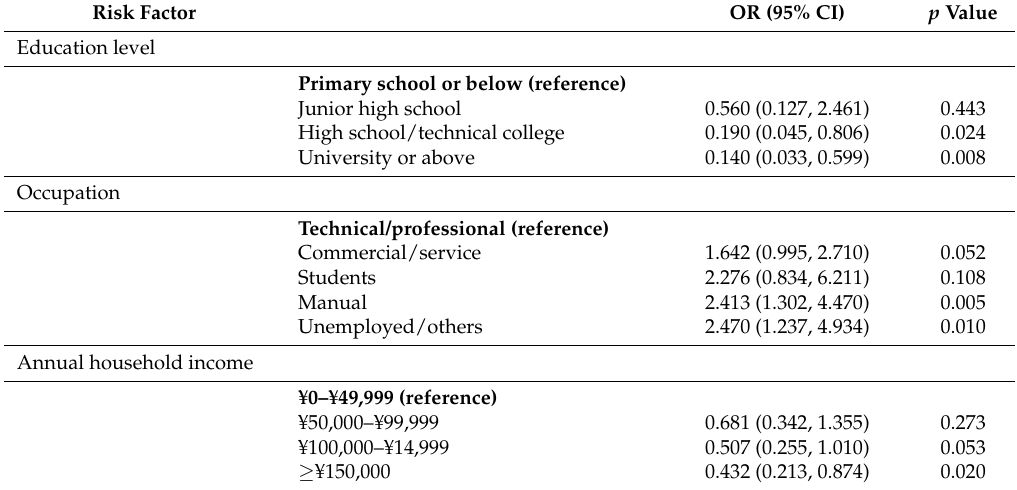
Table 1. Odds ratios in favor of low health literacy and 95% CI in the stepwise logistic regression model.